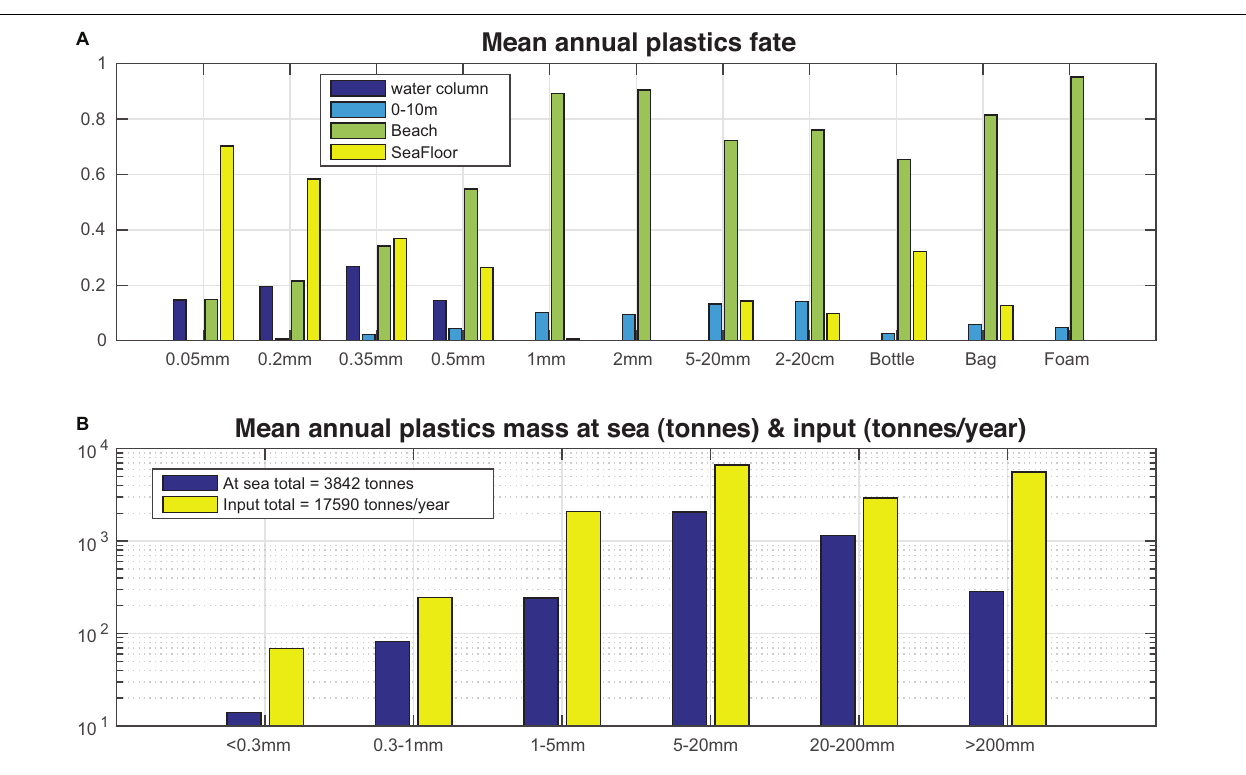
FIGURE 13 | Mean (2010–2017) model simulated (A) plastics percentage found in the near surface (0–10 m), water column ( > 10 m), beach and seafloor and (B) mean total plastics ( < 0.3, 0.2–1, 1–5, 5–20, 20–200, and > 200 mm) mass (tonnes) at sea (near surface and water column) and input from sources (tonnes/year).